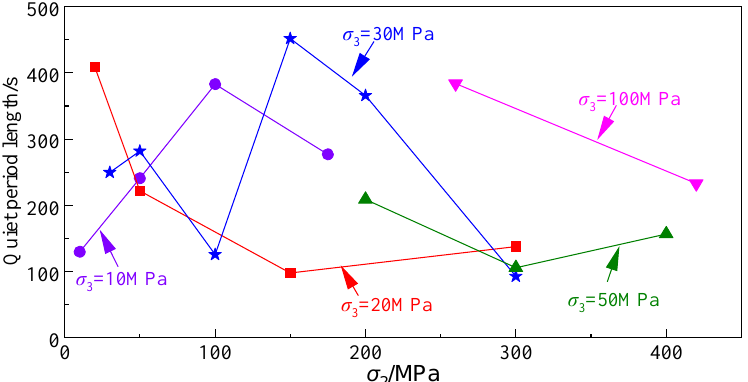
Figure 5. Quiet period under different true triaxial stresses. Table 1. Relationship between AE and σ 1 in the quiet period.